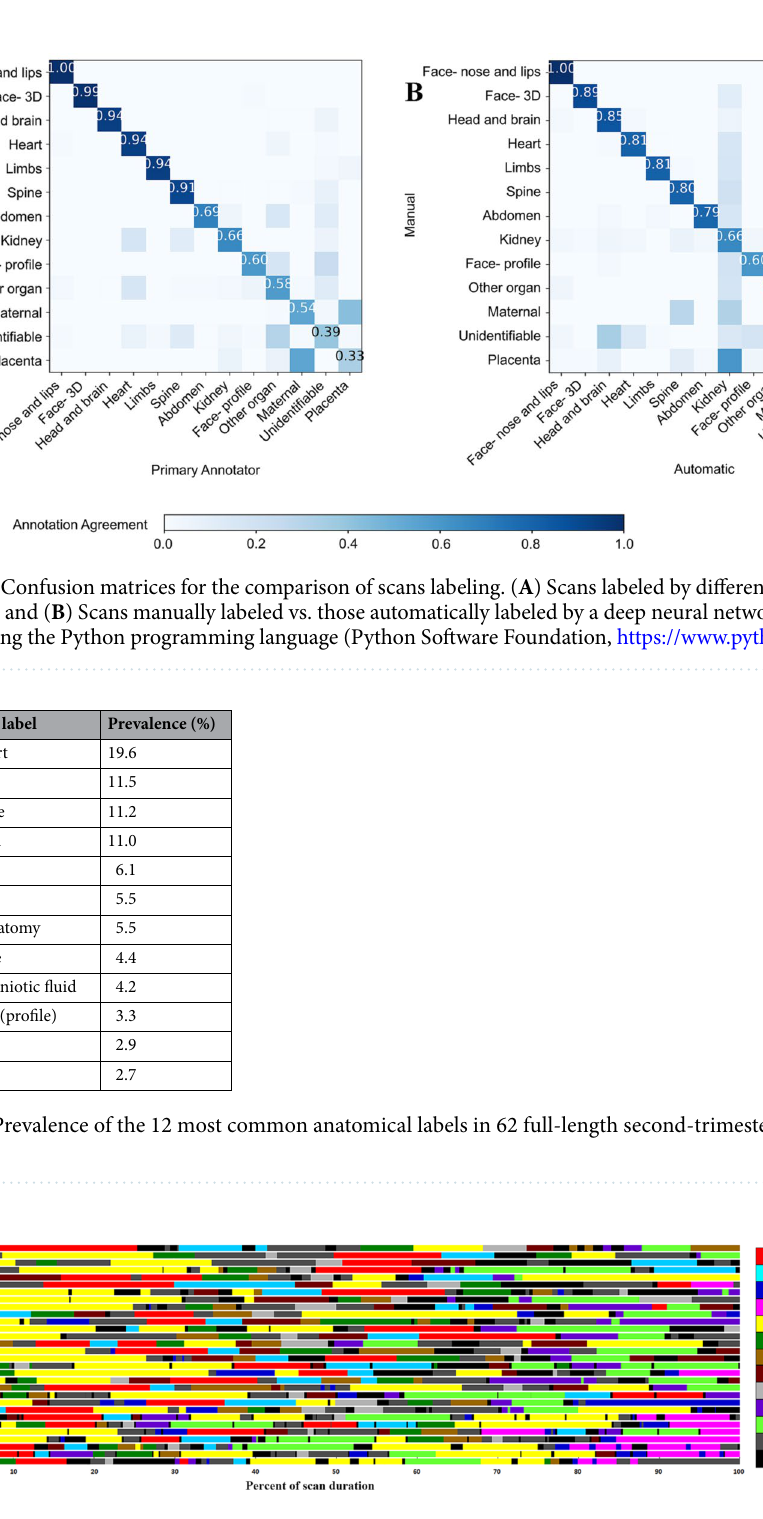
Figure 6. Anatomic plane being evaluated according to time (normalized to percent) in 25 representative anomaly scans. Figure created using MATLAB version 9.6 (https:// www. mathw orks.